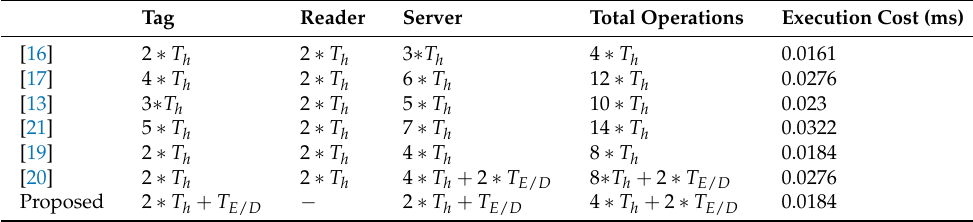
Table 9. Comparison of the computational